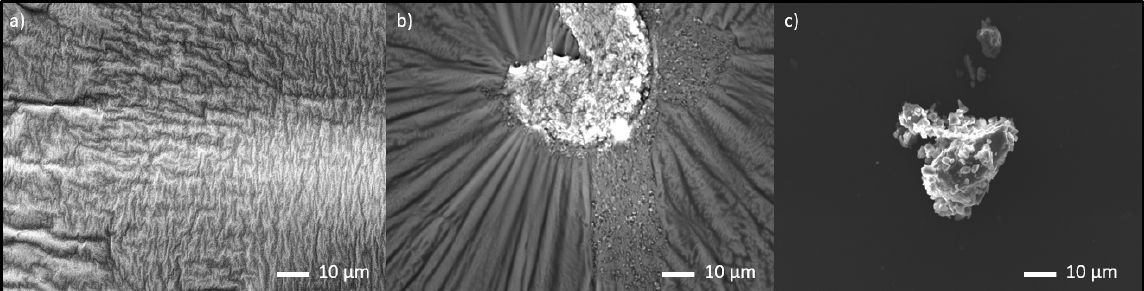
Figure 4. Scanning electron microscope images: ( a ) basic resin with no added species; ( b ) resin with nano-SiO 2 ; ( c ) resin with ZnAl-LDH.